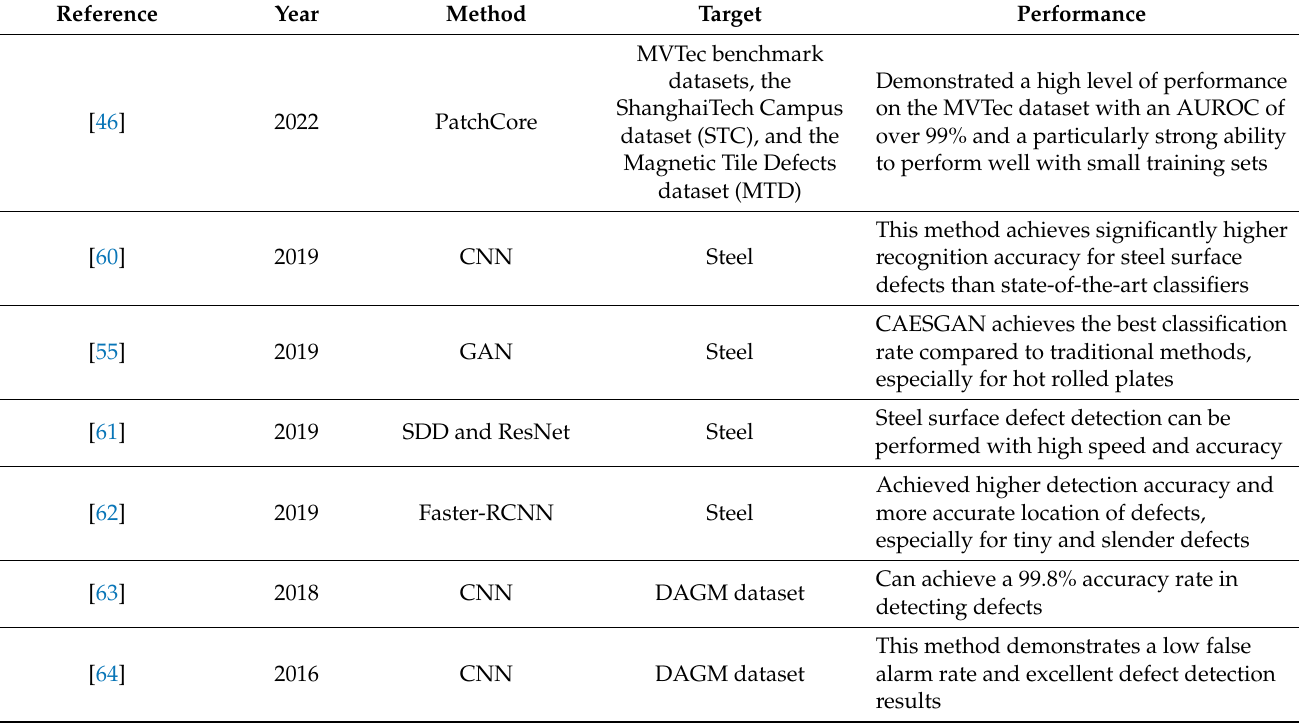
Table 3. An overview of recent research publications as well as classifications based on